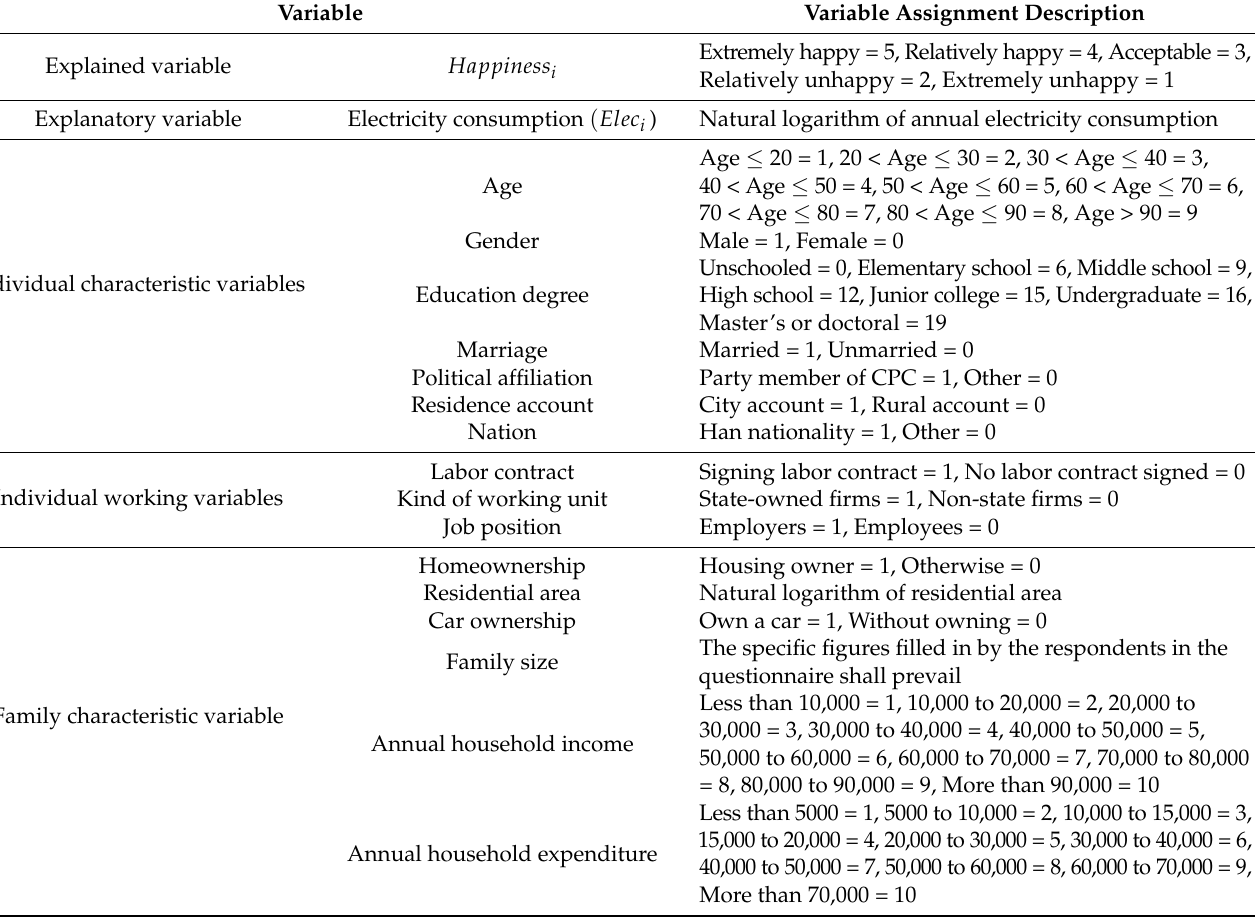
Table 1. Variable